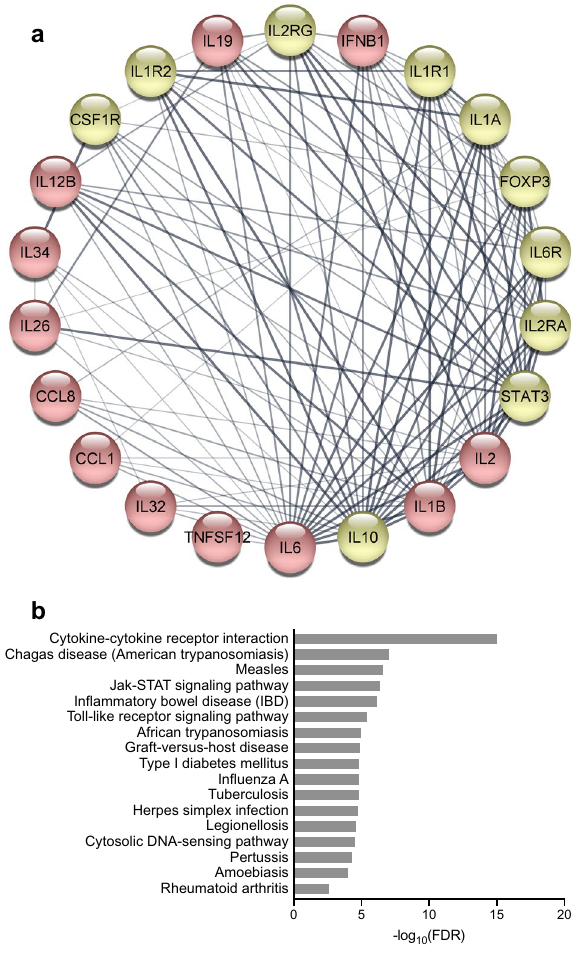
Figure 5. Relapse-associated biomolecular network. ( a ) Protein–protein interaction (PPI) networks of relapse-associated 12 target proteins shown in red were analyzed by STRING database with a confidence score of 0.4, and ten more related targets shown in yellow were identified. Line thickness indicates the strength of data support. ( b ) Top 16 pathways and rheumatoid arthritis pathways (ranked 28th out of 41 pathways) from KEGG pathway analysis of 12 relapse-associated proteins. X-axis (in bar graphs) indicates the significance (− log 10 [FDR]) of the pathway association. The PPI image was created using Cytoscape (ver. 3.8.2, https:// cytos cape. org). The pathway analysis image was created using GraphPad Prism 8 (http:// www. graph pad.